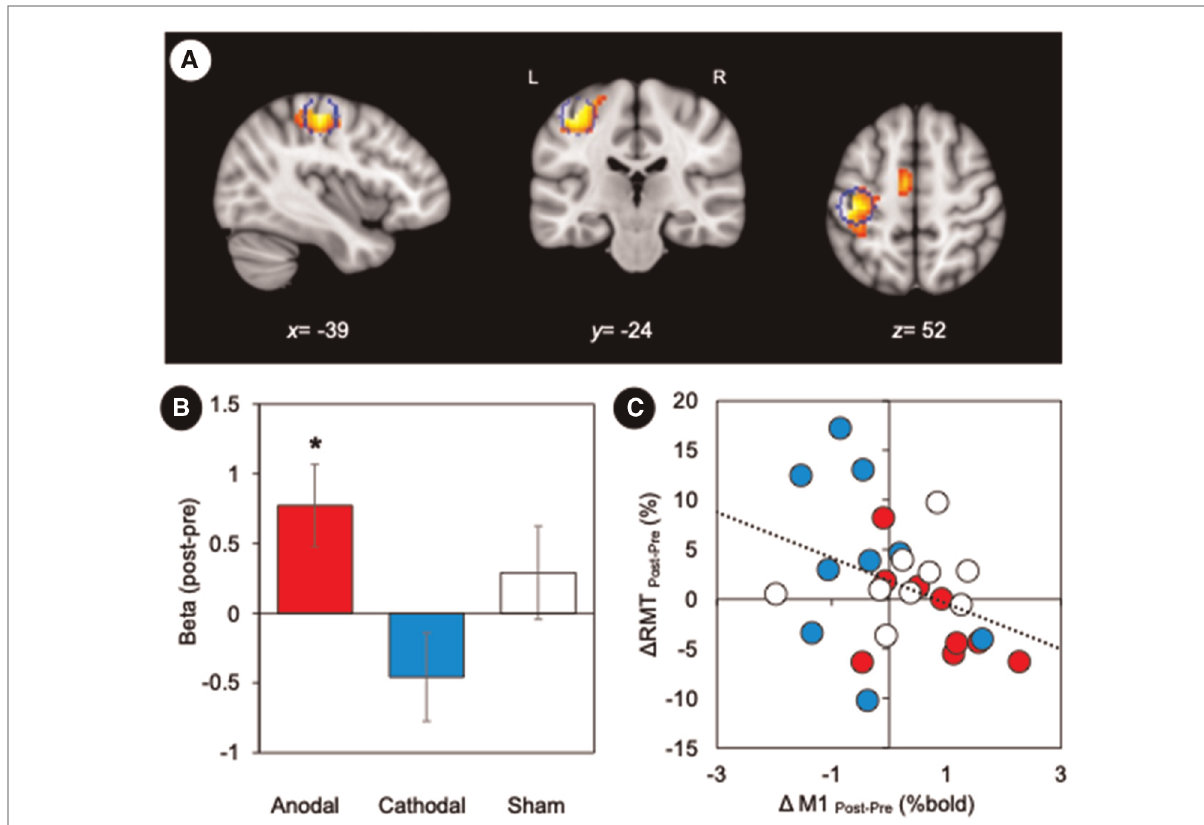
FIGURE 4 Motor cortex plasticity. ( A ) M1 location de fi ned by the maximally activated voxel in the contralateral (left) hemisphere. Statistical maps based on the conjunction map of the responses elicited by the hand motor task (pre-stimulation). The coordinates of the group maxima are reported on the structural images from the MNI template, and a sphere of 6 mm radius marked for reference. Coordinates of the group maxima of activation are reported in Table 1 . All images are displayed with a statistical signi fi cance of p <0.005 at the voxel level and p <0.05 (ks>30) at a cluster level with false-discovery rate (FDR) correction. ( B ) GLM parameter estimates (weighted beta values) representing the magnitude of M1 responses to tDCS stimulation. Error bars represent standard error. * p <0.05. ( C ) Relationship between changes in RMT and M1 activity. We found a signi fi cant negative correlation between RMT changes (post — pre) and M1 activity changes (post — pre) ( r = − 0.40, p